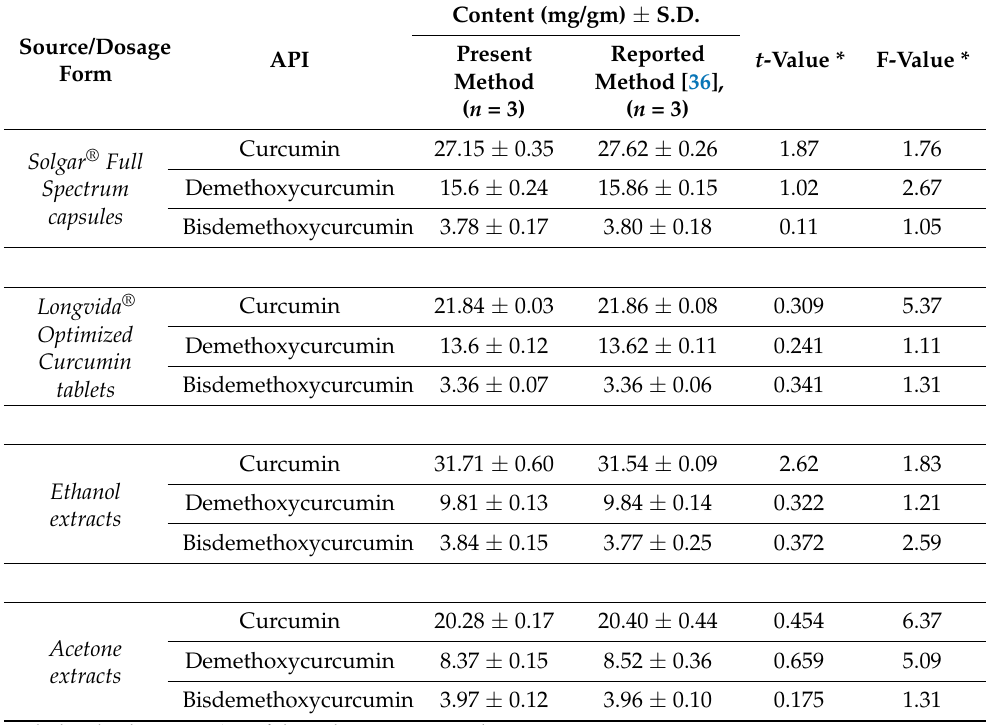
Table 8. Application of the proposed HPLC method for the analysis of the contents of curcuminoids ( µ g/mL) in Curcuma longa powder extract and pharmaceutical dosage